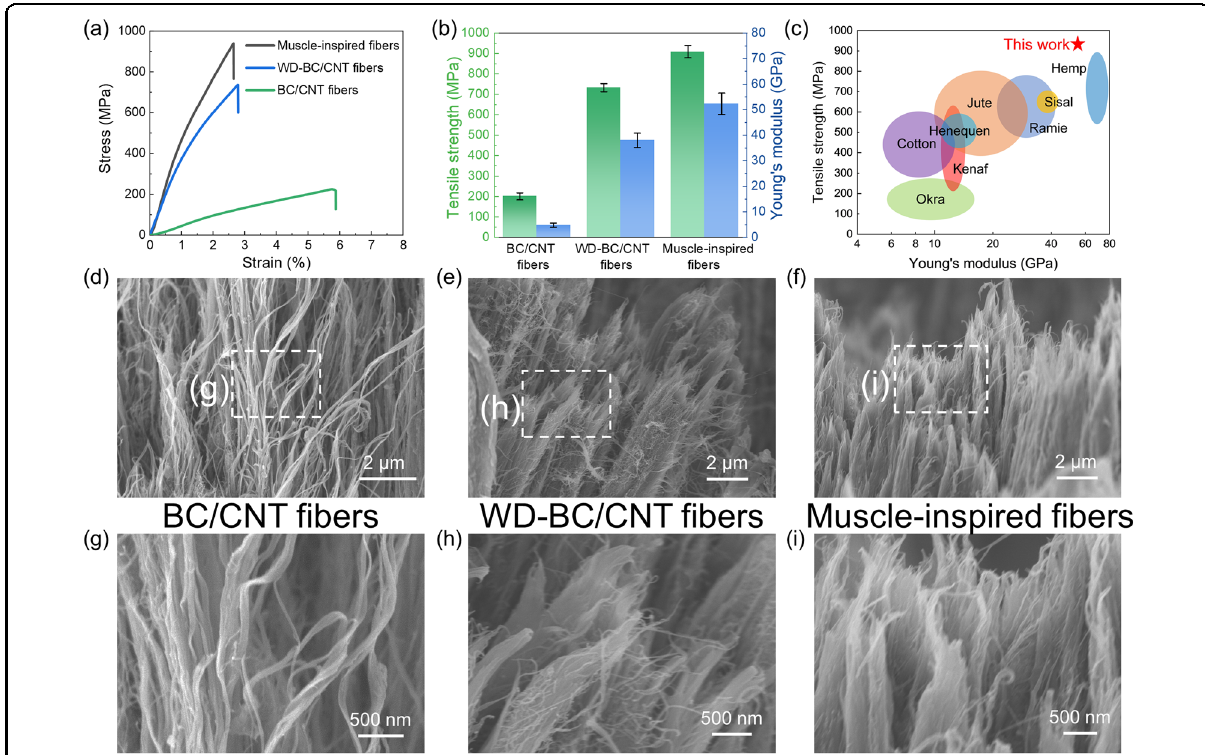
Fig. 3 Mechanical properties of the muscle-inspired fi bers (15.9 wt% CNT). a Tensile stress – strain curves of the muscle - inspired fi bers, WD-BC/ CNT fi bers, and BC/CNT fi bers. b Comparison of the tensile strength and stiffness of the muscle-inspired fi bers, WD-BC/CNT fi bers, and BC/CNT fi bers. c Ashby diagram of tensile strength vs. stiffness for the muscle-inspired fi ber compared with natural plant fi bers. d , g SEM images of BC/CNT fi bers, showing a loose network structure. g shows the enlarged view of the area framed in d . e , h SEM images of WD-BC/CNT fi bers, showing a dense oriented structure. h shows the enlarged view of the area framed in e . f , i SEM images of the muscle-inspired fi bers, showing a tight combination of BC and CNTs. i shows the enlarged view of the area framed in f